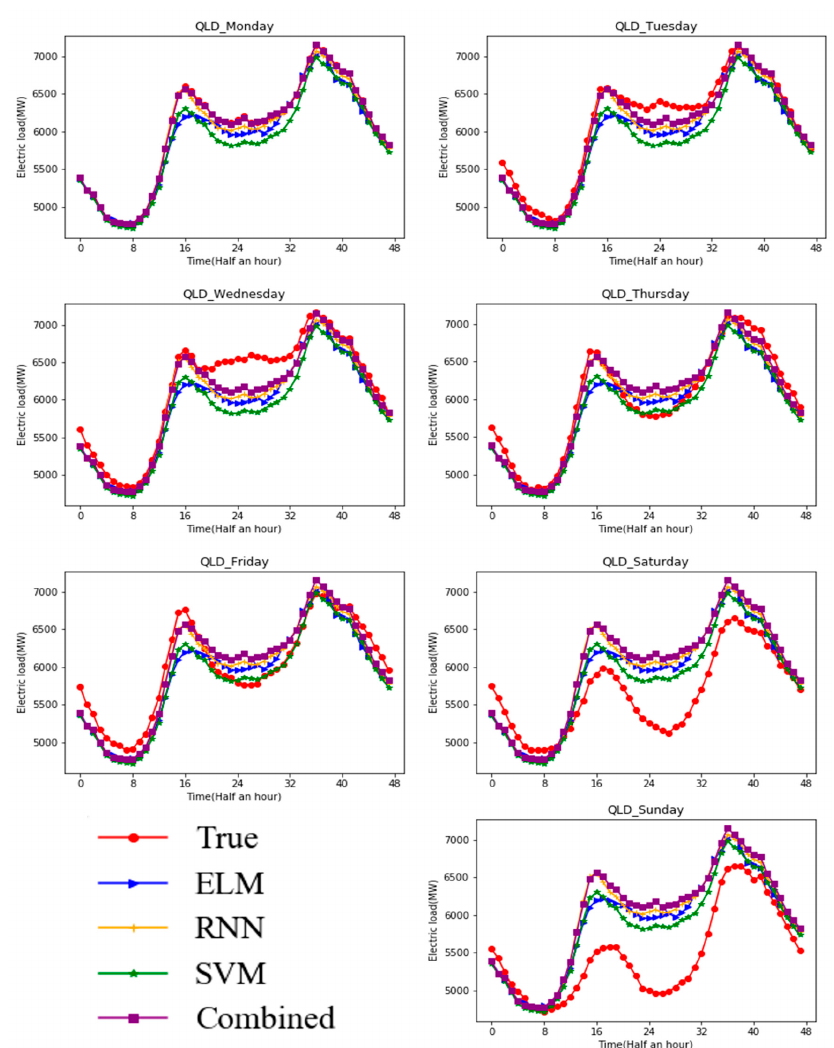
Figure 7. Comparison of forecasting performances of four models for Queensland in a week. Table 5. Results of the three evaluation metrics of the four models for Queensland.